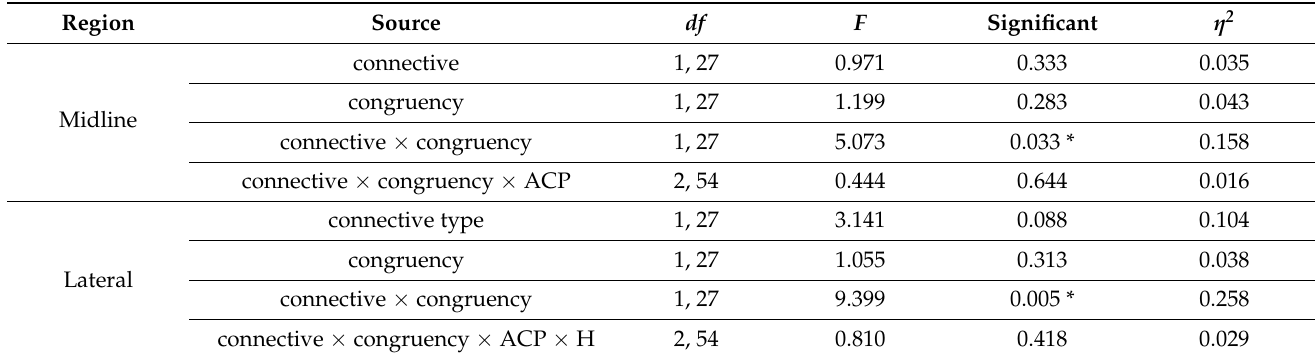
Table A1. The results of ANOVAs on mean amplitude at the critical words in the 300–800 ms time window.